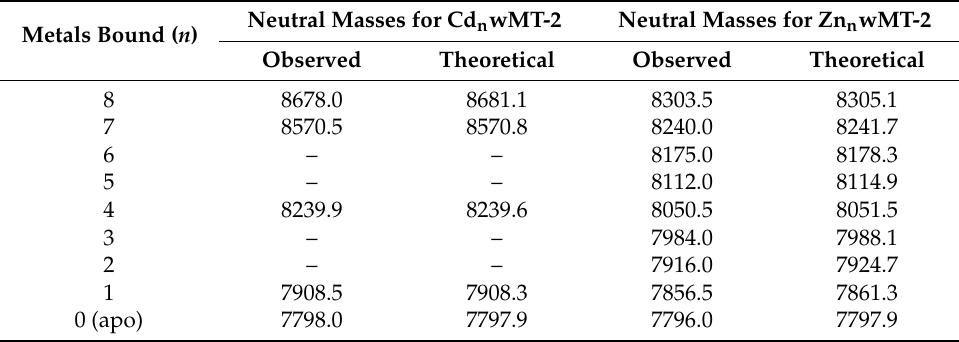
Table 1. Theoretical and observed masses for species detected during pH titrations of Cd- and